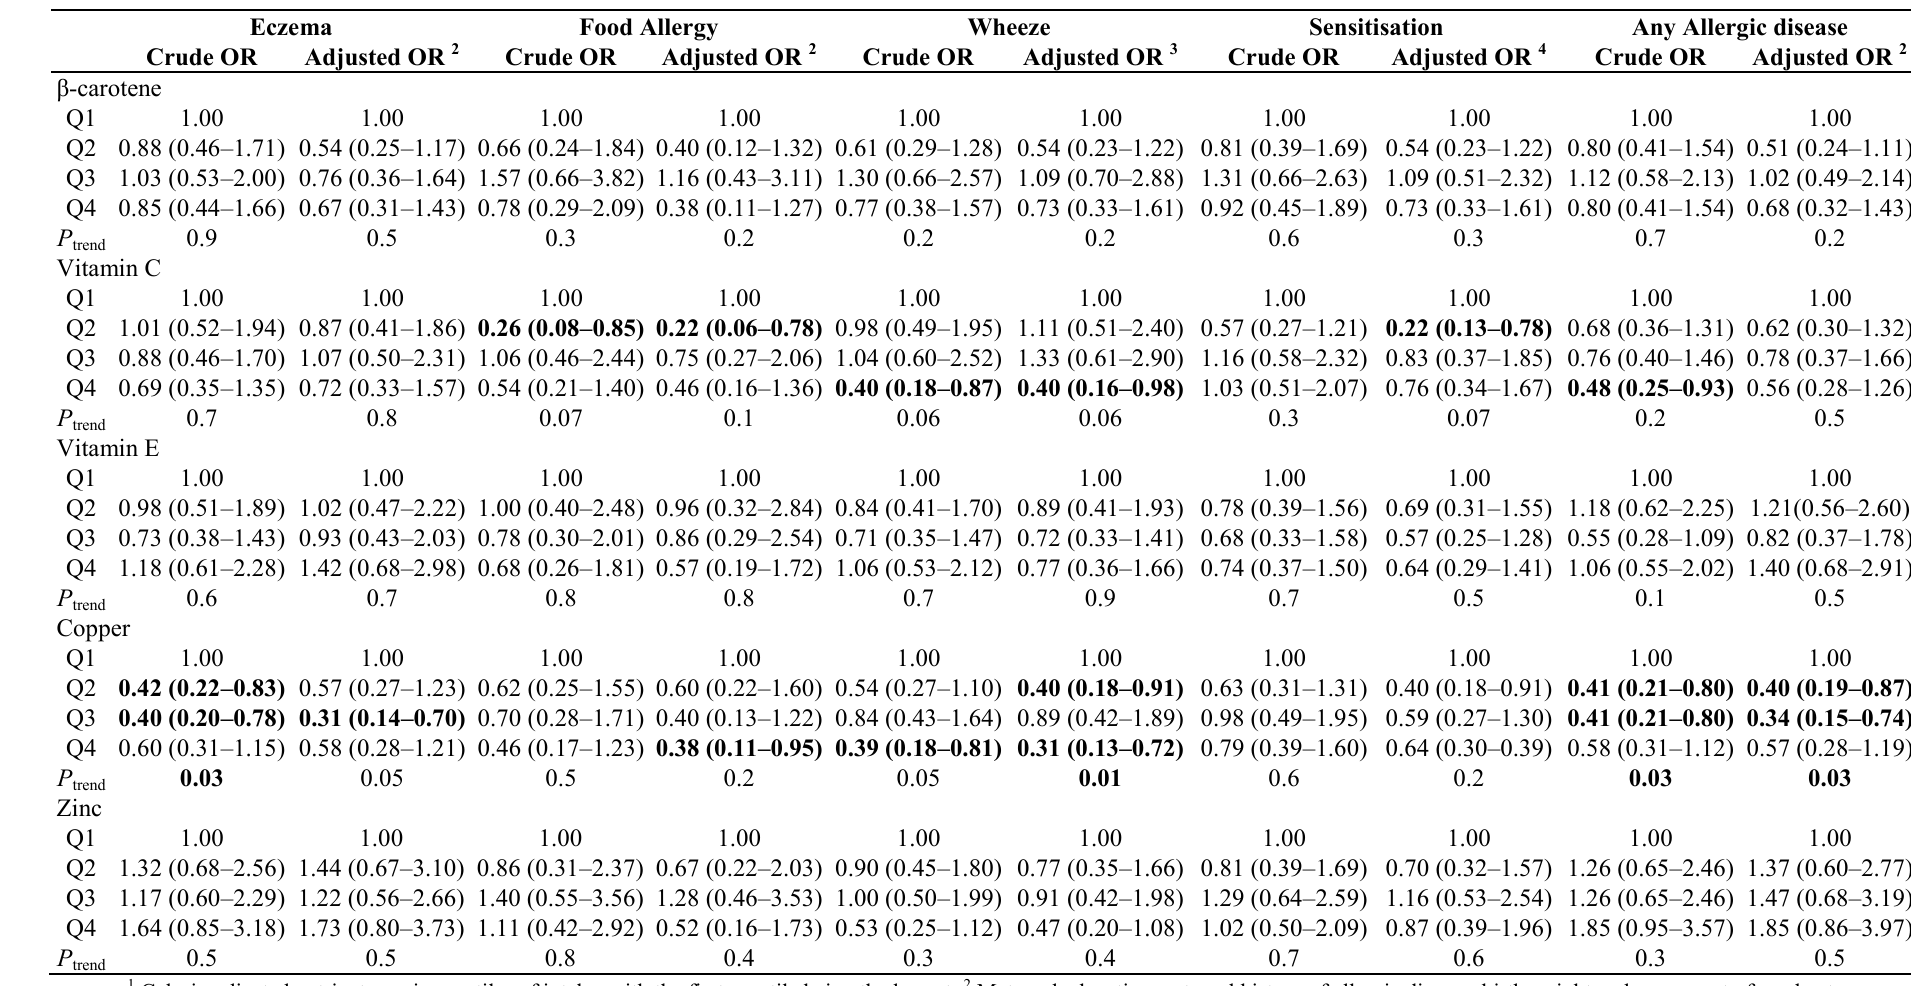
Table 4. ORs and 95% CIs for 12 month allergic outcomes by quartiles of maternal dietary antioxidant intake in pregnancy in 300 mother-infant pairs 1